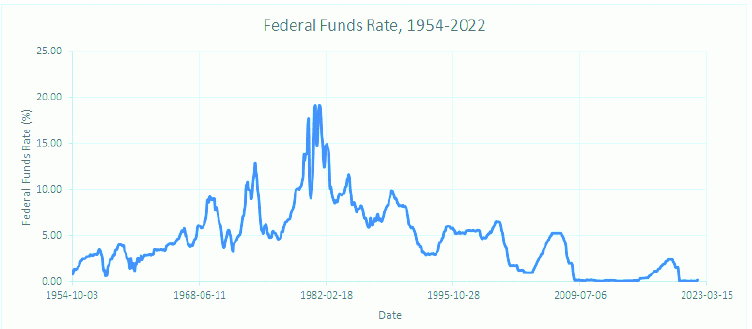
Figure 12. The historical record of federal funds rate. Actual margin rates may be about one percent higher. Data: (ffunds 2022). For nearly 15 years, we have been living in an era of low interest rates. That now appears to be changing.